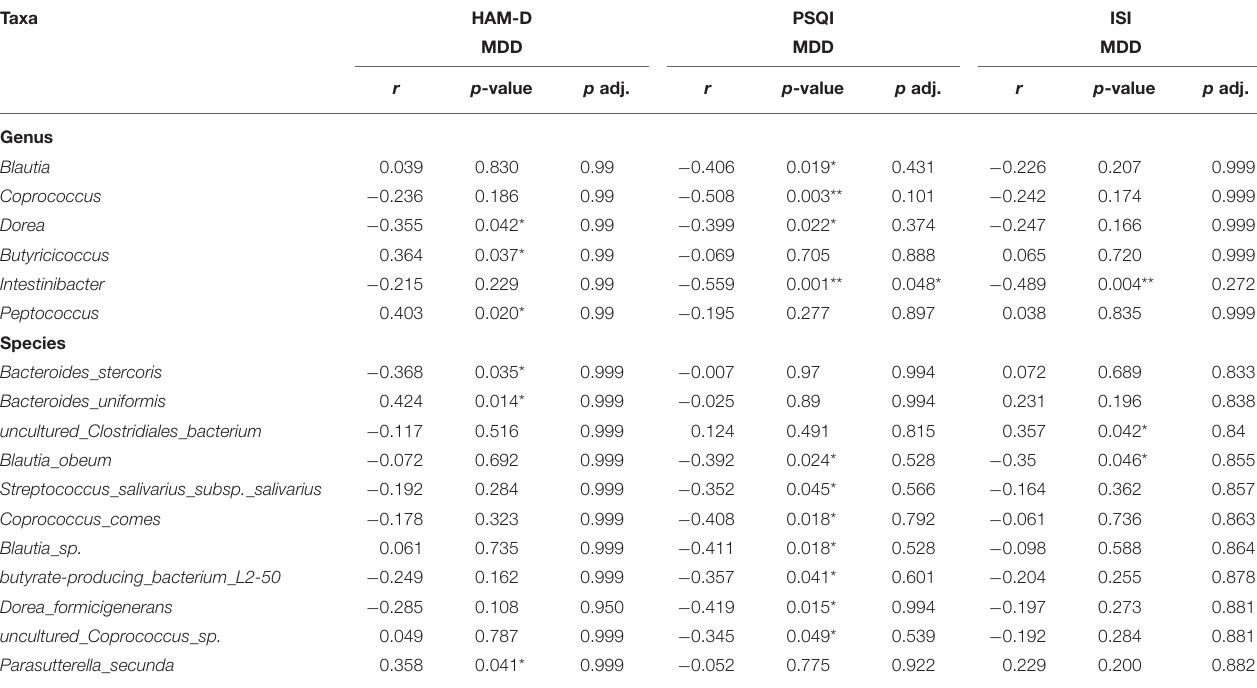
TABLE 3 | Partial correlations between taxa and HAM-D, PSQI, and ISI scores in MDD. Taxa